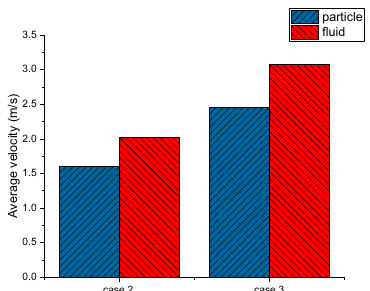
Figure 13. Average velocities of fluid and particles under Case 2 and 3.